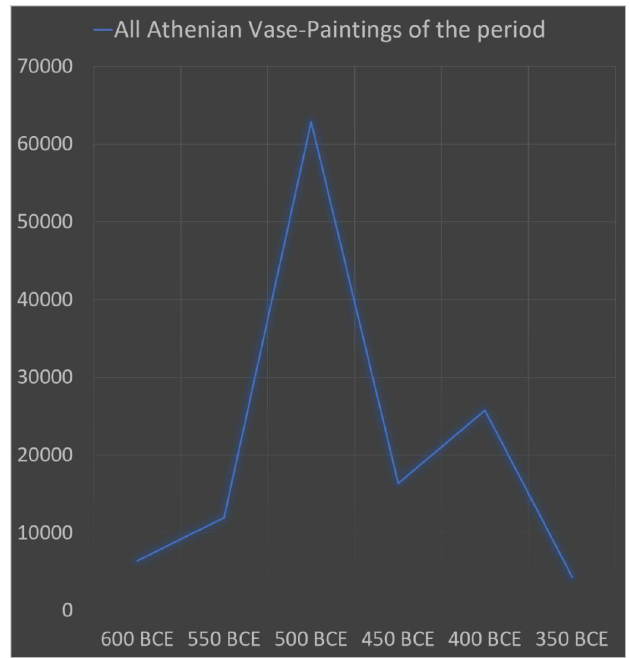
Figure 2. Relative numbers of Athenian vase-paintings grouped by approximate dates. Data from the Beazley Archive Pottery Database (BAPD). Chart created by author.